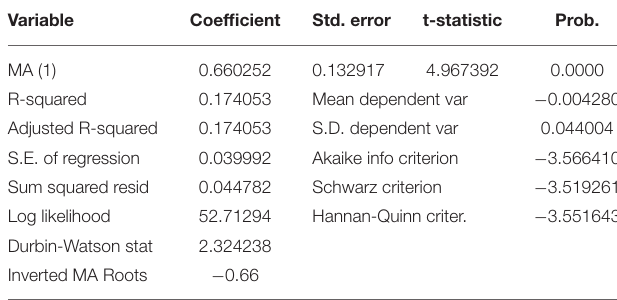
TABLE 4 | ARIMA (0, 1, 1) model fitting